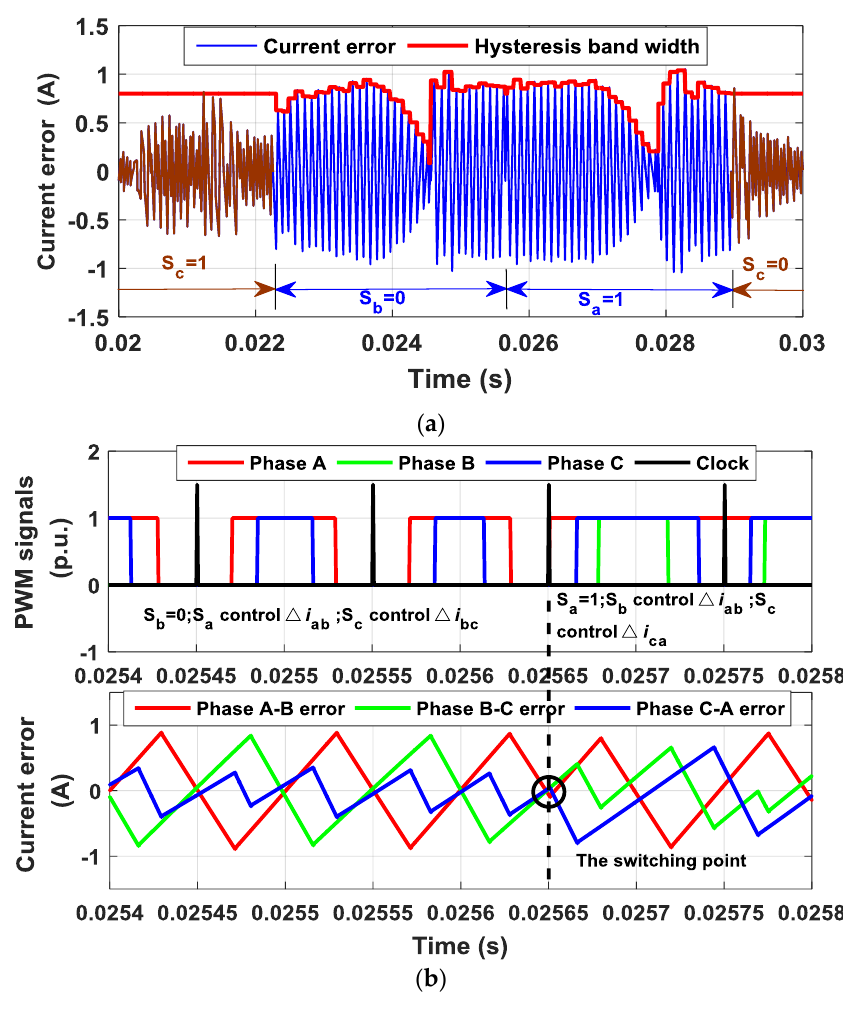
Figure 15. The performance of the current errors obtained by ST-FHCC. ( a ) Δ i ab and bandwidth obtained by ST-FHCC; ( b ) detailed current errors at the switching point.